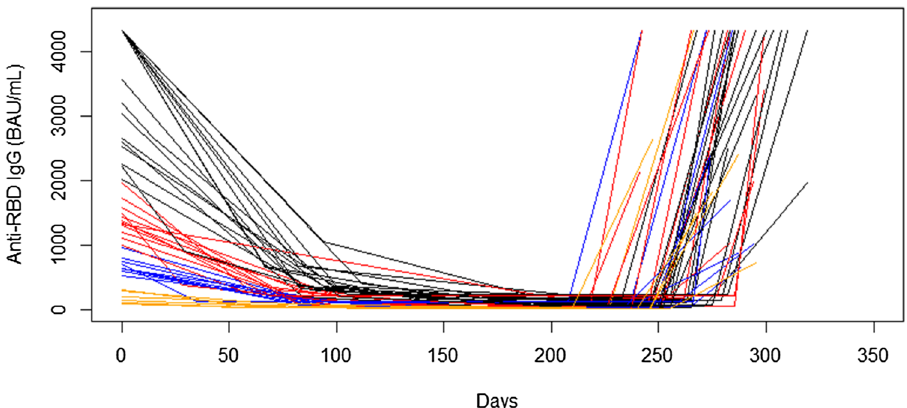
Figure 2. Line plot for the IgG anti-S-RBD reactivity kinetics before and after the booster dose. Days were counted from the first measurement (about 1 month after immunization). For each line, the point at the beginning of the last ascending segment represents the day of the booster dose. The colour of the line represents anti-S-RBD IgG levels reached after immunization (black: > 2000 BAU/mL, red: 1000–2000 BAU/mL, blue: 500– 1000 BAU/mL, orange: < 500 BAU/mL). IgG levels are truncated at 4330 BAU/mL, the maximum measurable level (samples with higher titers were not diluted).